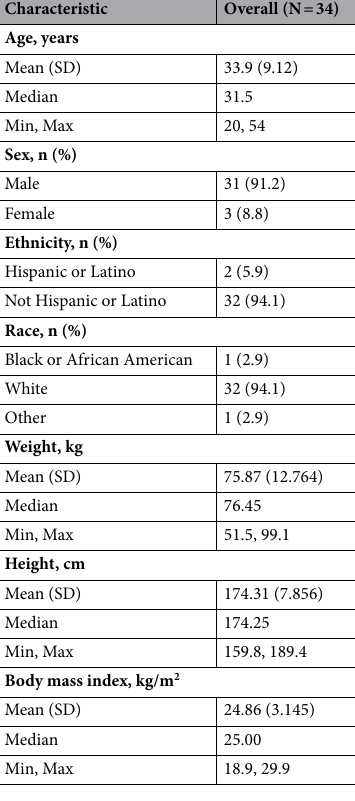
Table 1. Demographic and baseline characteristics of the safety population. Max maximum, Min minimum, SD standard